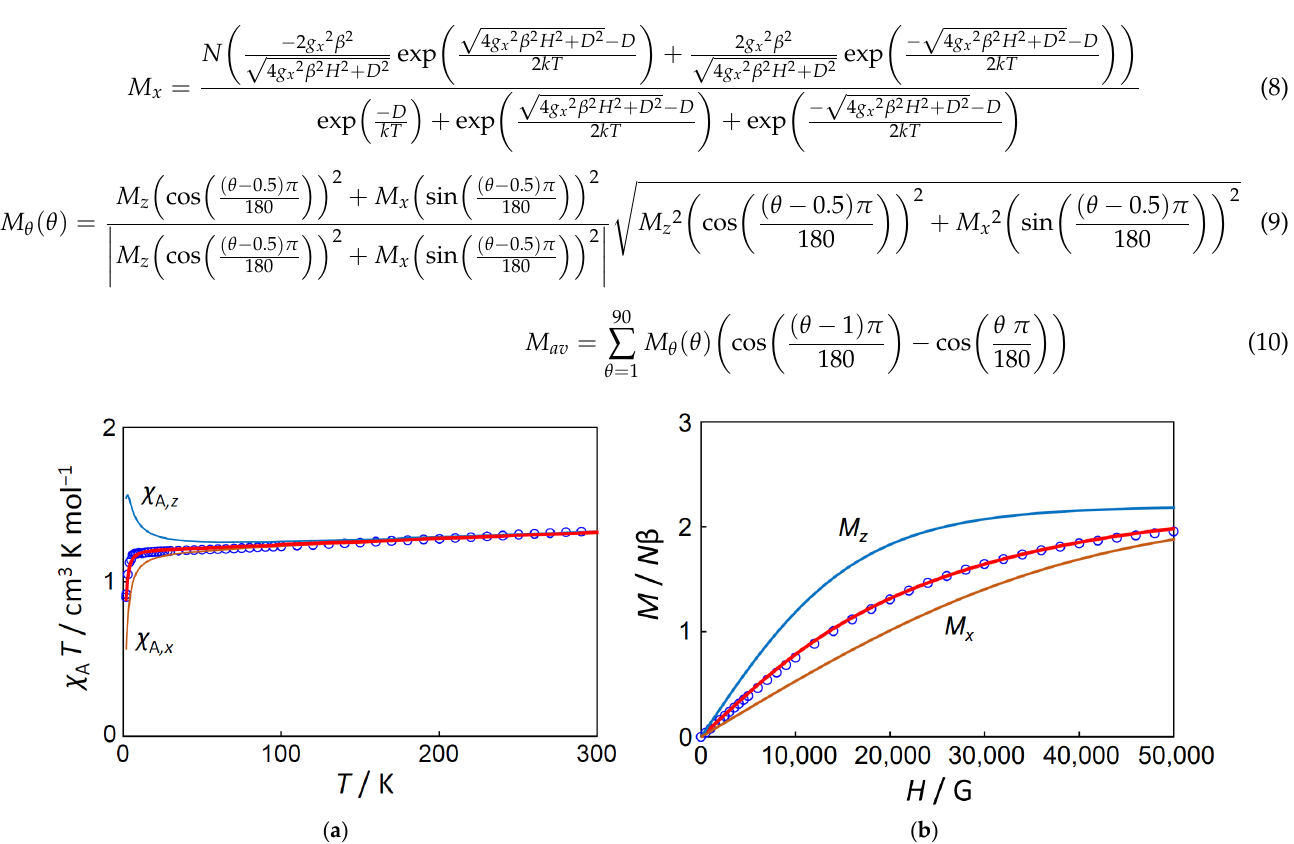
Figure 5. The χ A T vs. T plot and M vs. H plot for 1 . The observed data ( ○ ) and theoretical curves ( ‒ for average, ‒ for the z component, and ‒ for the x component) with the best-fitting parameter set ( g , D , zJ , χ tip ) = (2.19, − 3.5 cm − 1 , − 0.40 cm − 1 , 398 × 10 − 6 cm 3 mol − 1 ). ( a ) The χ A T vs. T plot; ( b ) The M vs. H plot.